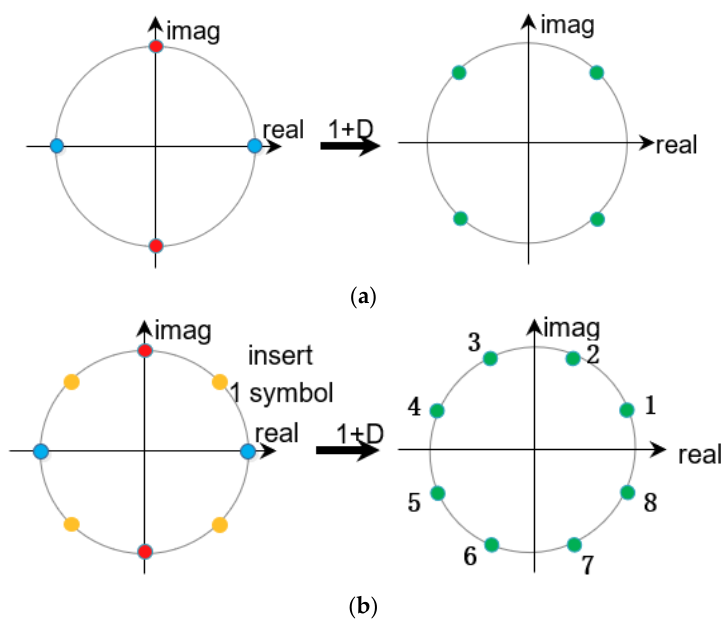
Figure 2. (1 + D) pi/2(N + 1) BPSK modulation. ( a ) (1 + D) pi/2 BPSK (N = 0); ( b ) (1 + D) pi/4 BPSK (N = 1).